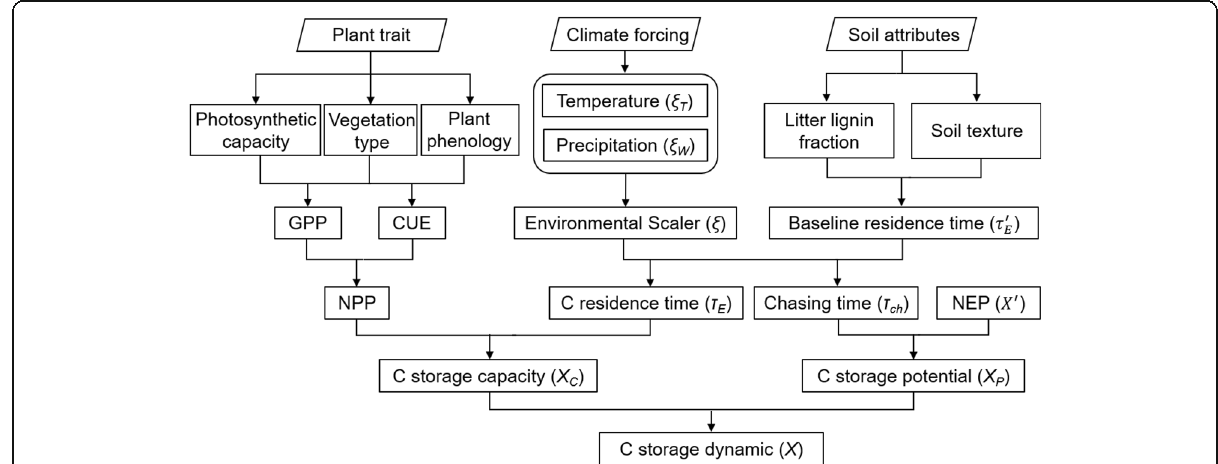
Fig. 2 The theoretical framework of traceability analysis. The transient carbon (C) storage dynamic ( X ) can be decomposed into carbon storage capacity ( X c) and potential ( X p). Then, the net primary productivity (NPP) and ecosystem C residence time ( τ E ) can explain the C storage capacity. NPP can be traced to gross primary productivity (GPP) and carbon use efficiency (CUE). τ E can be traced to environmental scalars ( ξ ) and baseline C residence time ( τ 0 E ). These traceable components can be explained by related